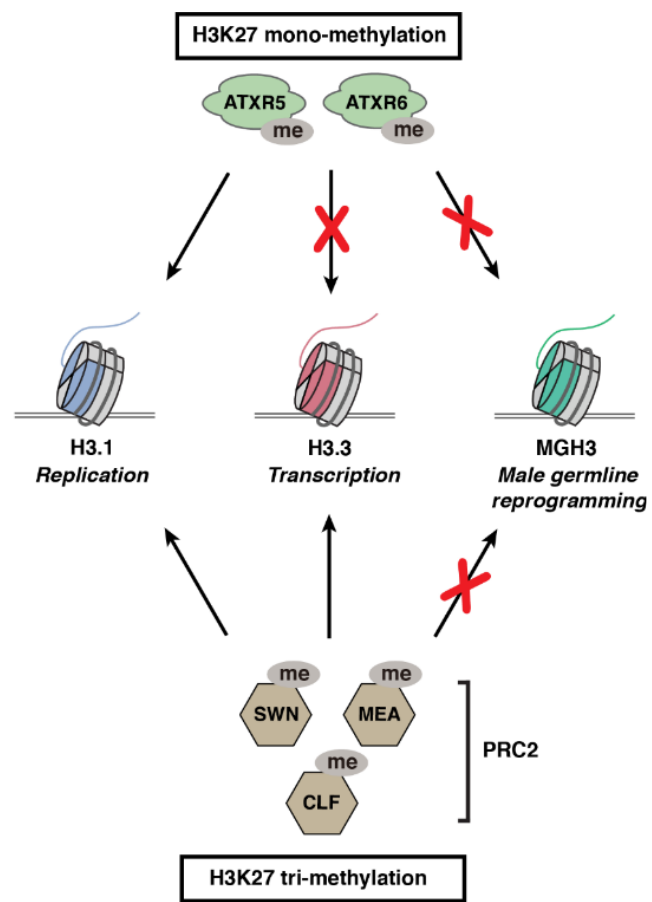
Figure 2. Activity of plant H3K27 methyltransferases on different H3 variants. ATXR5 and ATXR6 catalyze K27 monomethylation on H3.1 variants. PRC2 complexes containing either CLF, MEA, or SWN (catalytic subunits of Arabidopsis PRC2 complexes) trimethylate K27 on H3.1 and H3.3 vari- ants. In contrast, ATXR5, ATXR6, and PRC2 complexes cannot methylate the male-gamete-specific histone variant MGH3, which contributes to reprograming the paternal epigenome in pollen of Ara- bidopsis.